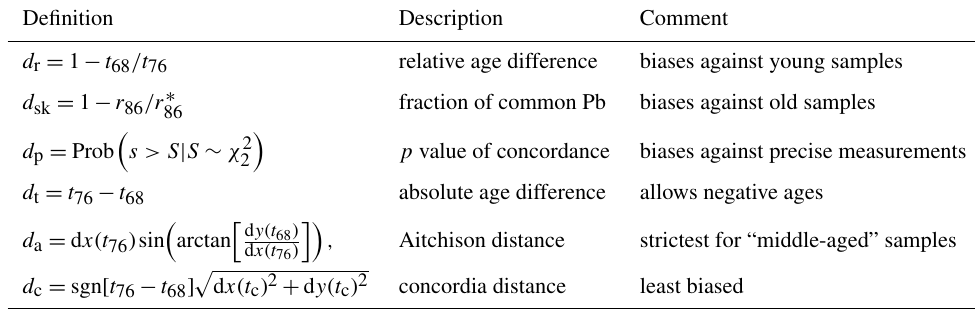
Table 2. Side-by-side comparison of the different discordance